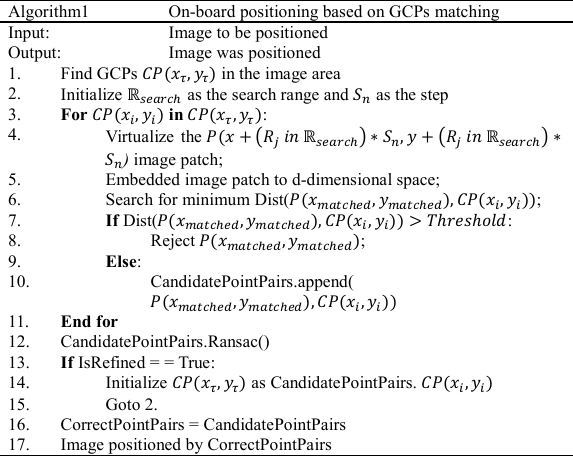
Figure 4. China (Songshan) satellite remote sensing calibration field. The red cross in the picture is the center of the selected GCPs image. The light blue box is the matching experiment area, which is located in the verification